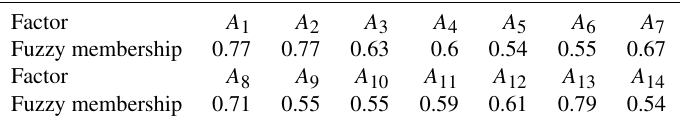
Table 3. The fuzzy memberships of Type A factors.